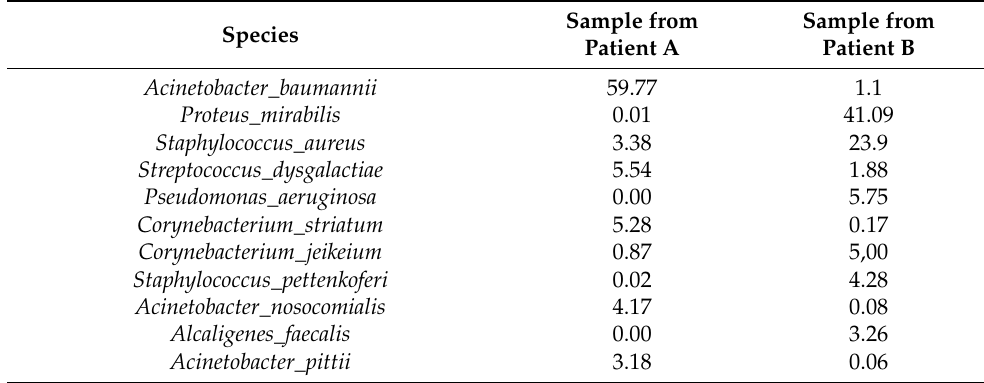
Table 1. Relative abundance (%) of the bacterial species found in samples from Patient A and Patient B. Only species present with an abundance >0.01% are